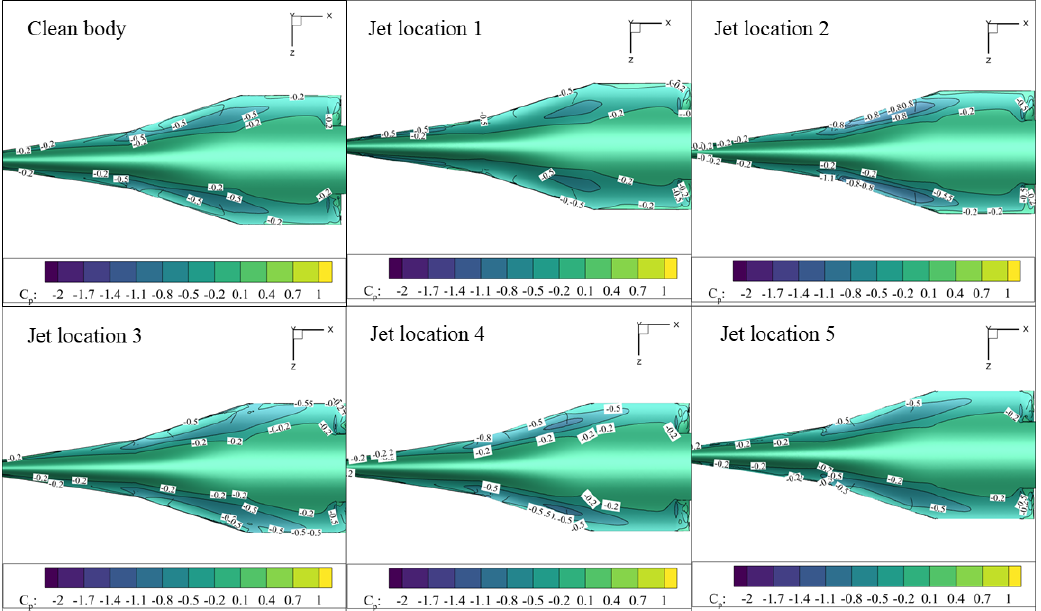
Figure 12. Comparison of the pressure coefficient contours on the upper surfaces for different jet locations at α = 10 ◦ .